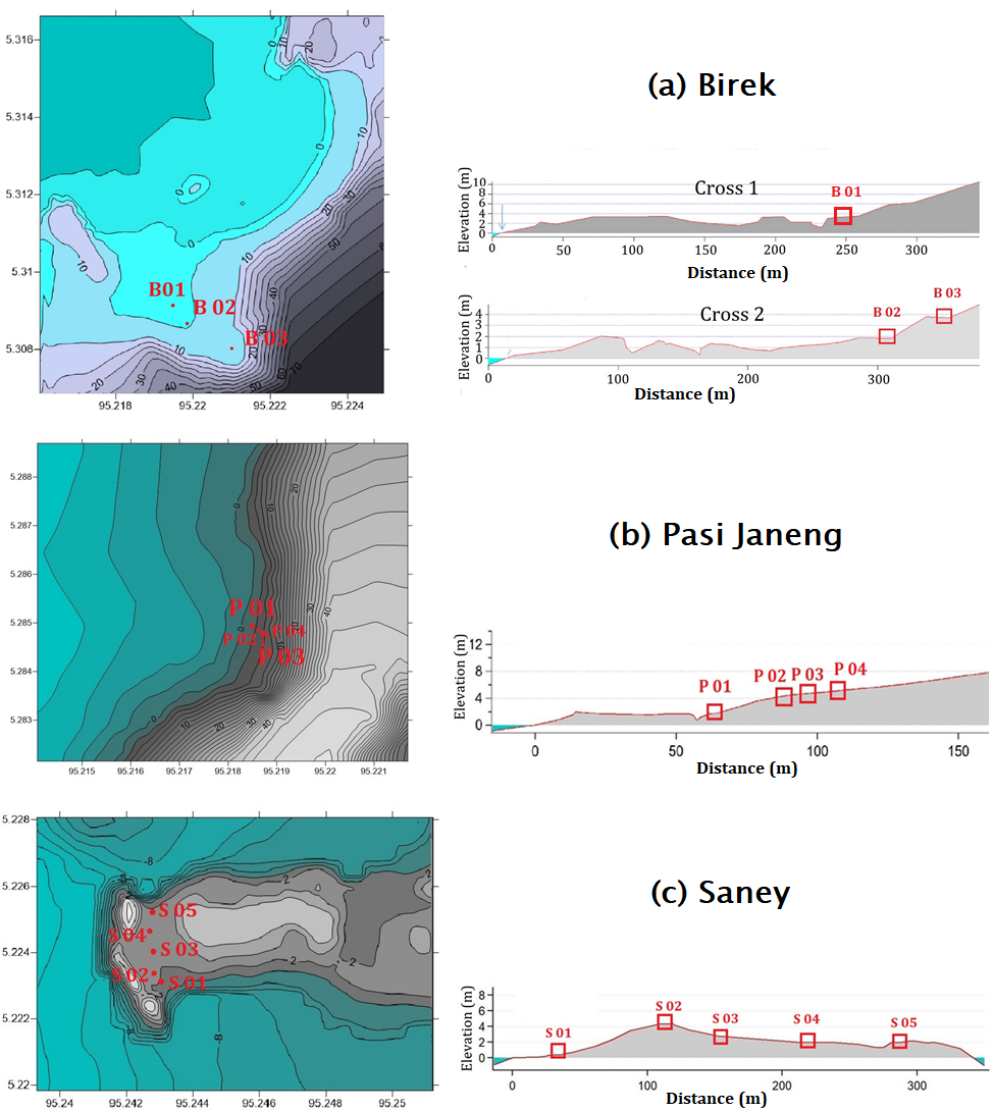
Figure 5. The topographic profiles at Birek and the locations of the pit tests (B01–B03), Pasie Janeng (P01–P04), and Saney